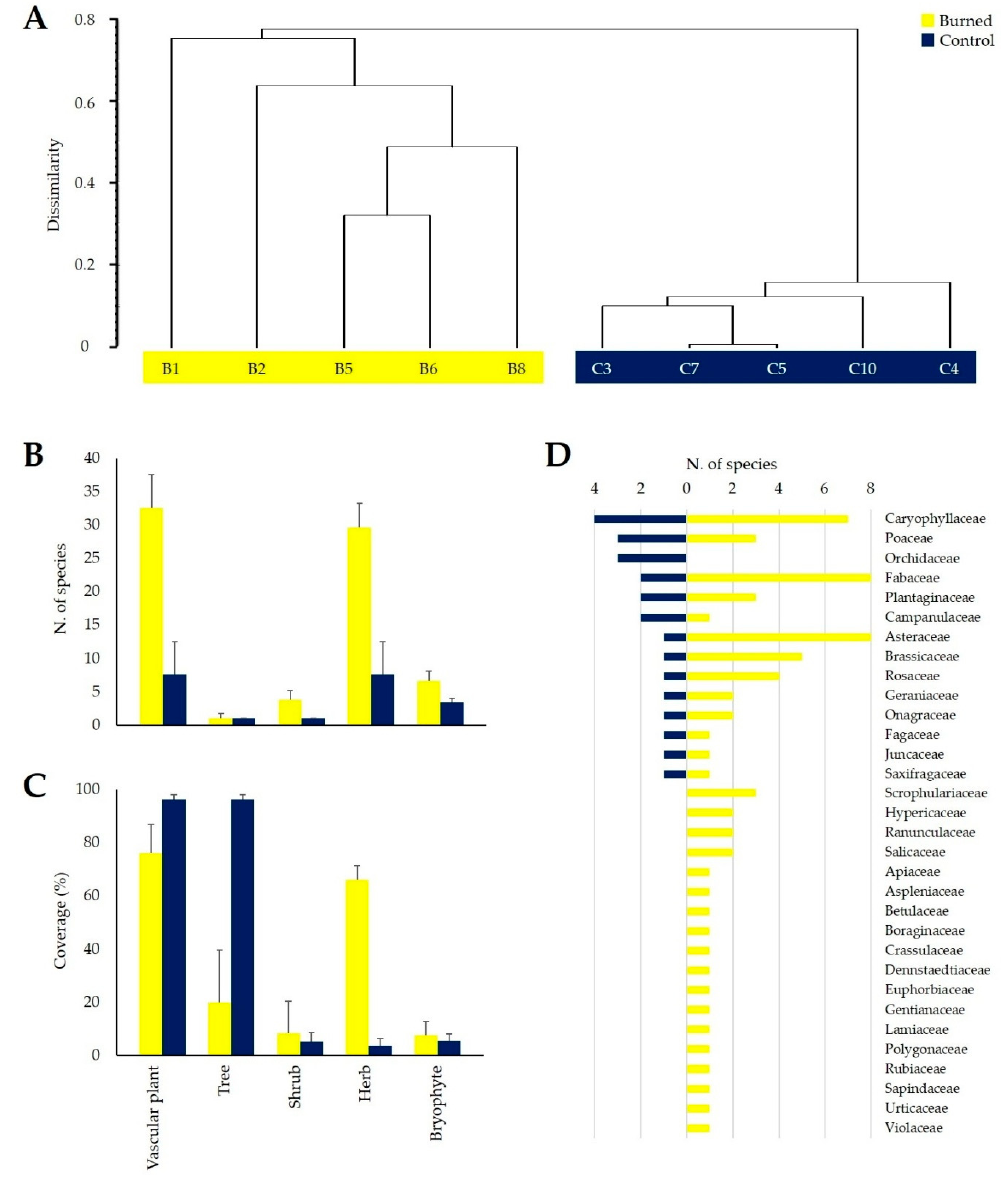
Figure 3. Dendrogram of cluster analysis ( A ) based on vascular plants coverage data using the average linkage (UPGMA) as the agglomeration criterion and the Similarity ratio as dissimilarity index. Comparison between burned and control areas in terms of species richness ( B ) and coverage ( C ) in total vascular plant community (Vascular plant), tree layer (Tree), shrub layer (Shrub), herbaceous layer (Herb), and bryophyte layer (Bryophyte) (mean + standard deviation, and raw data are available in Table S2). Number of plant species within each plant family in burned and control plots ( D ) (total values).